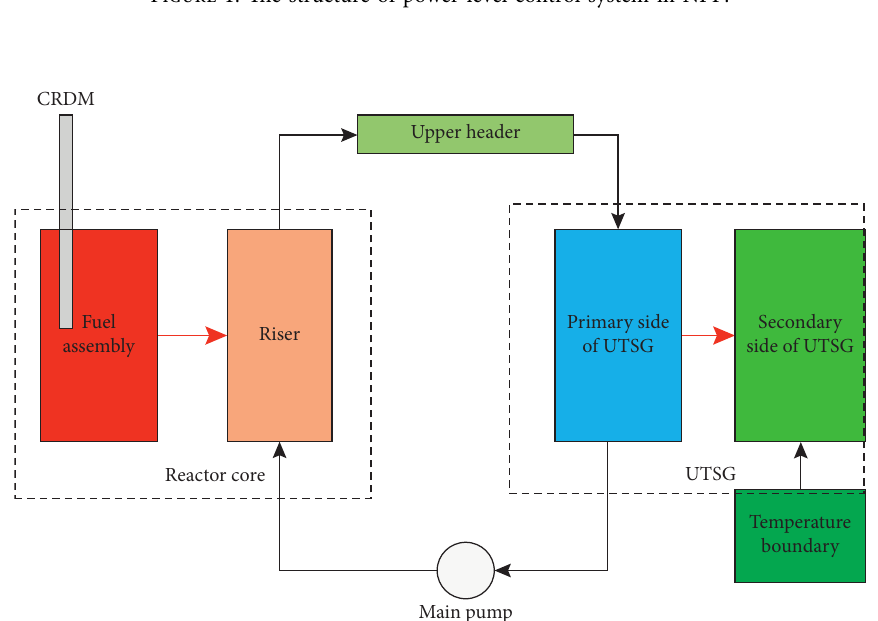
Figure 2: Nodalization scheme of the whole plant module of